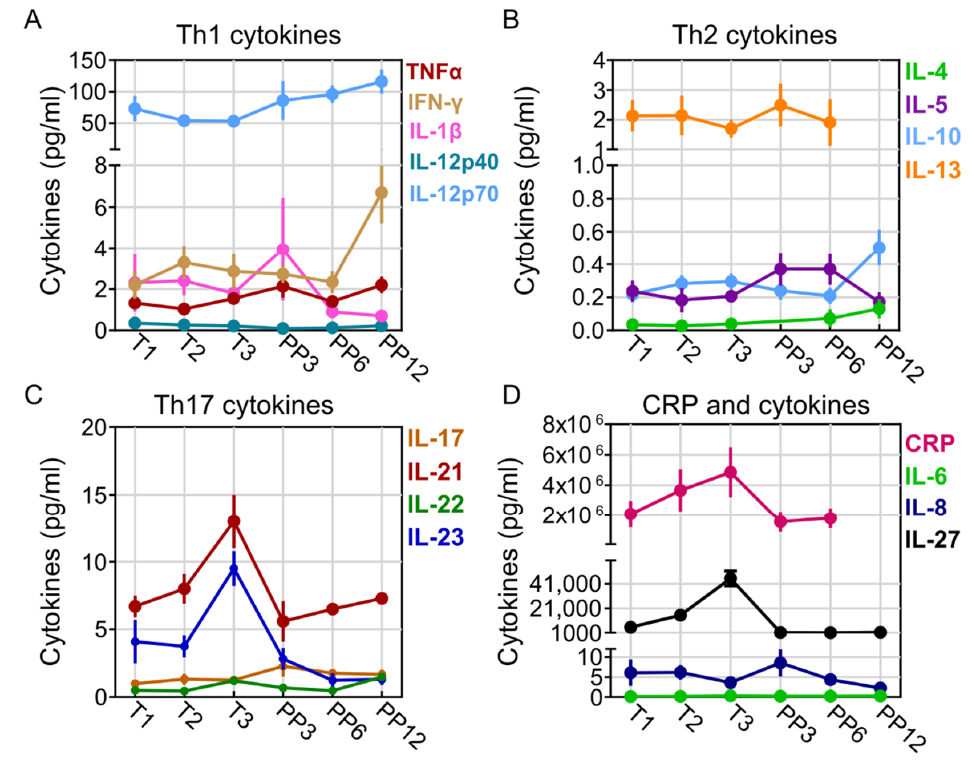
Figure 1. Pregnancy-related cytokine changes in healthy women. ( A ) Th1-cytokines TNF α , IFN- γ , IL-1 β , IL-12p40, and IL-12p70 throughout pregnancy (N = 5–11 per time point). ( B ) Th2-cytokines IL-4, IL-5, IL-10, and IL-13 throughout pregnancy (N = 5–11 per time point). ( C ) Th17-cytokines IL-17, IL-21, IL-22, and IL-23 throughout pregnancy (N = 5–11 per time point). ( D ) CRP and cytokines IL-6, IL-8, and IL-27 throughout pregnancy (N = 5–11 per time point).